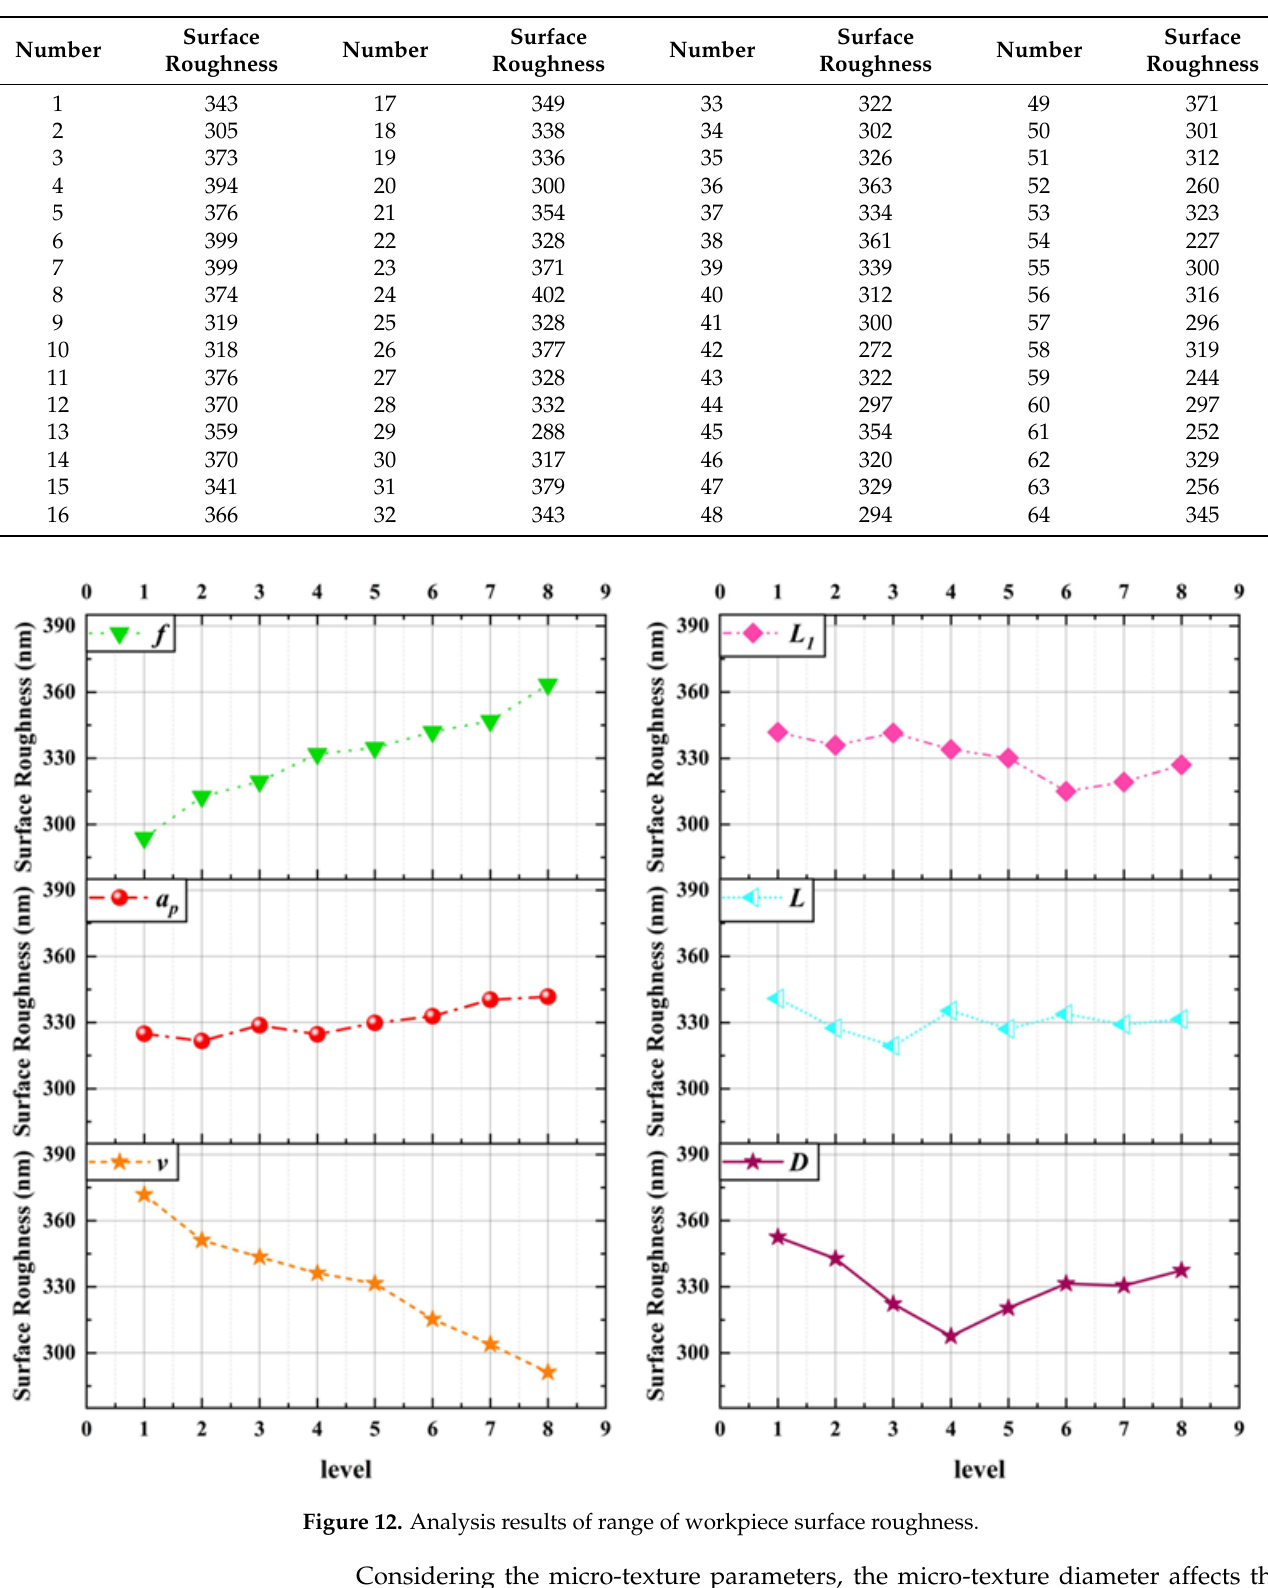
Table 4. Experimental results of workpiece surface roughness (nm).